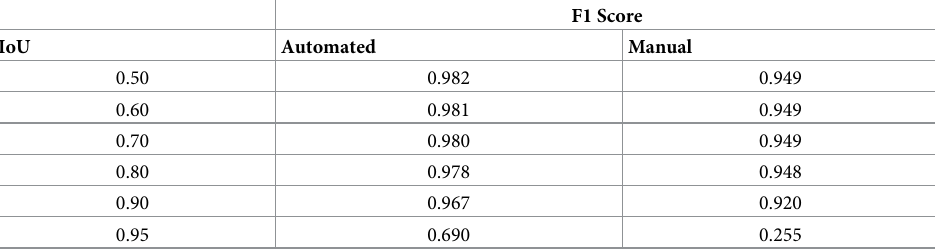
Table 2. F1 score of segmented nuclei images trained on an automatically and a manually annotated dataset.